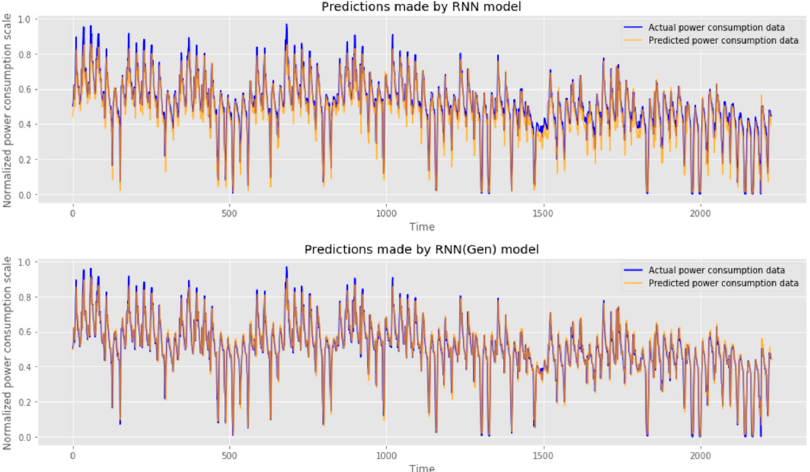
Figure 8. Comparison of performance between existing RNN model ( top ) and optimized RNN model ( bottom ).